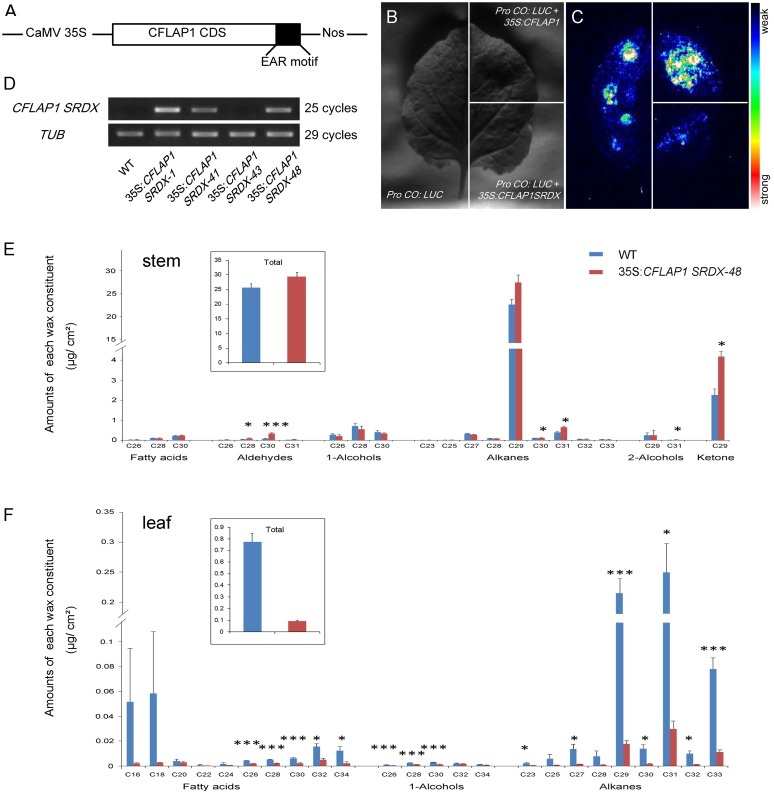
35S:CFLAP1SRDX plants had opposite phenotypes to 35S:CFLAP1 plants.(A) The schematic diagram of 35S:CFLAP1SRDX construct. CaMV35S, CFLAP1 CDS, EAR motif and Nos represent the 35S promoter, CFLAP1 coding sequence, the repression domain of 12 amino acid residues, and the NOS terminator sequence, respectively. (B) and (C) Transient effector-reporter expression assay in tobacco leaves, with the CO promoter driving a luciferase gene as a reporter, and the 35S:CFLAP1 and 35S:CFLAP1SRDX as effectors. Luminescence imaging is shown 48 hours after co-infiltration with the constructs indicated at left. (D) The result of RT-PCR. From right to left, wild type, transgenic lines 35S:CFLAP1SRDX-1, 35S:CFLAP1SRDX-41, 35S:CFLAP1SRDX-43, and 35S:CFLAP1SRDX-48, respectively.TUB2 was used as an internal control. (E) Epicuticular wax components of 35S: CFLAP1SRDX-48 and wild-type stems. Numbers indicate the main chain length of each constituent. Each value is the mean + SD of three biological replicates. At least 5 individual stems were used for each replicate. (F) Epicuticular wax components of 35S: CFLAP1SRDX-48 and wild-type rosette leaves. Numbers indicate the main chain length of each constituent. Each value is the mean + SD of three biological replicates. At least 7 individual rosette leaves were used for each replicate. Level of significance obtained with a Student’s t test is marked by the following: *, p<0.05; ***, p<0.01.